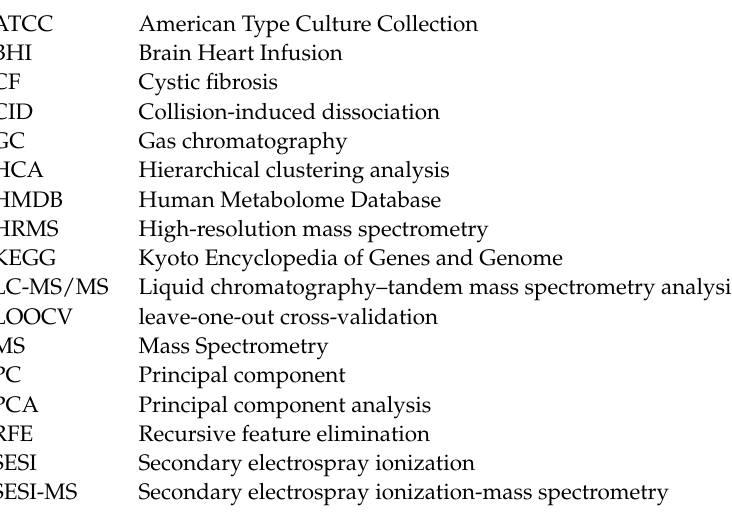
putative assignmen, Table S1: Alignement Table TripleTOF 5600+, Table S2: Target list with structure, Table S3: Putative markers literature comparison, Table S4: Plausibility control, Table S5: List of putatively identified